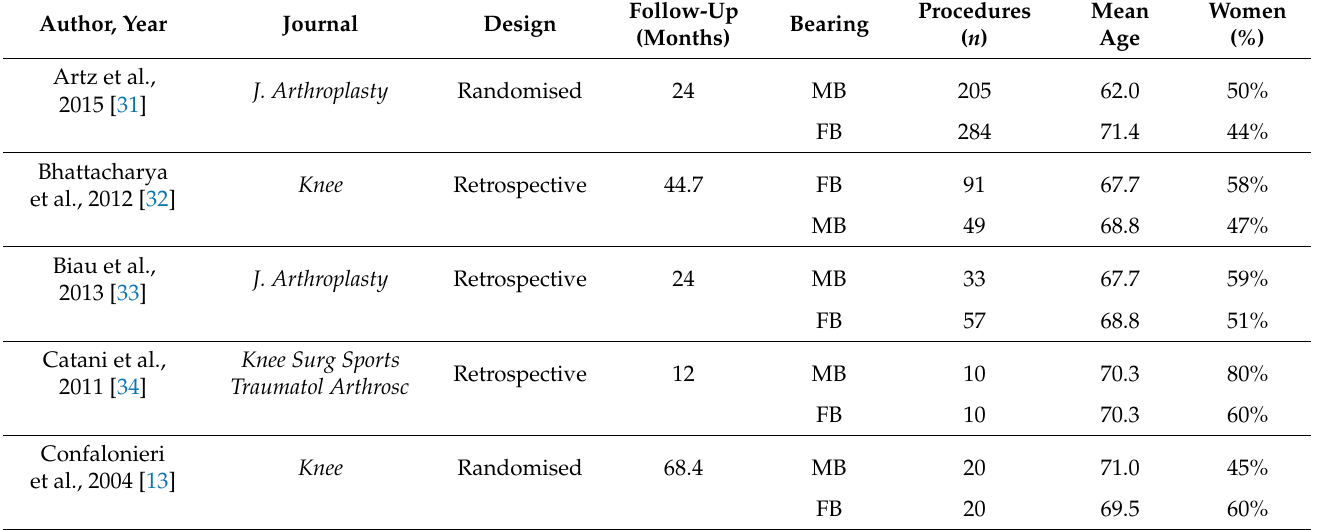
Table 1. Generalities and patient baseline of the included studies (MB: mobile bearing; FB: fixed bearing).